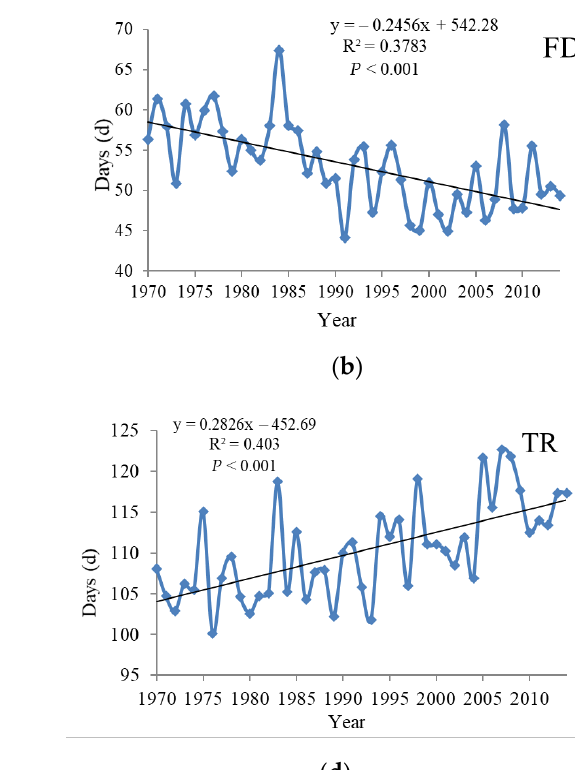
Figure 4. Temporal variation of the absolute indices of extreme temperature in the Yangtze River Basin from 1970 to 2014. ( a ) is ID, ( b ) is FD, ( c ) is SU and ( d ) is TR.